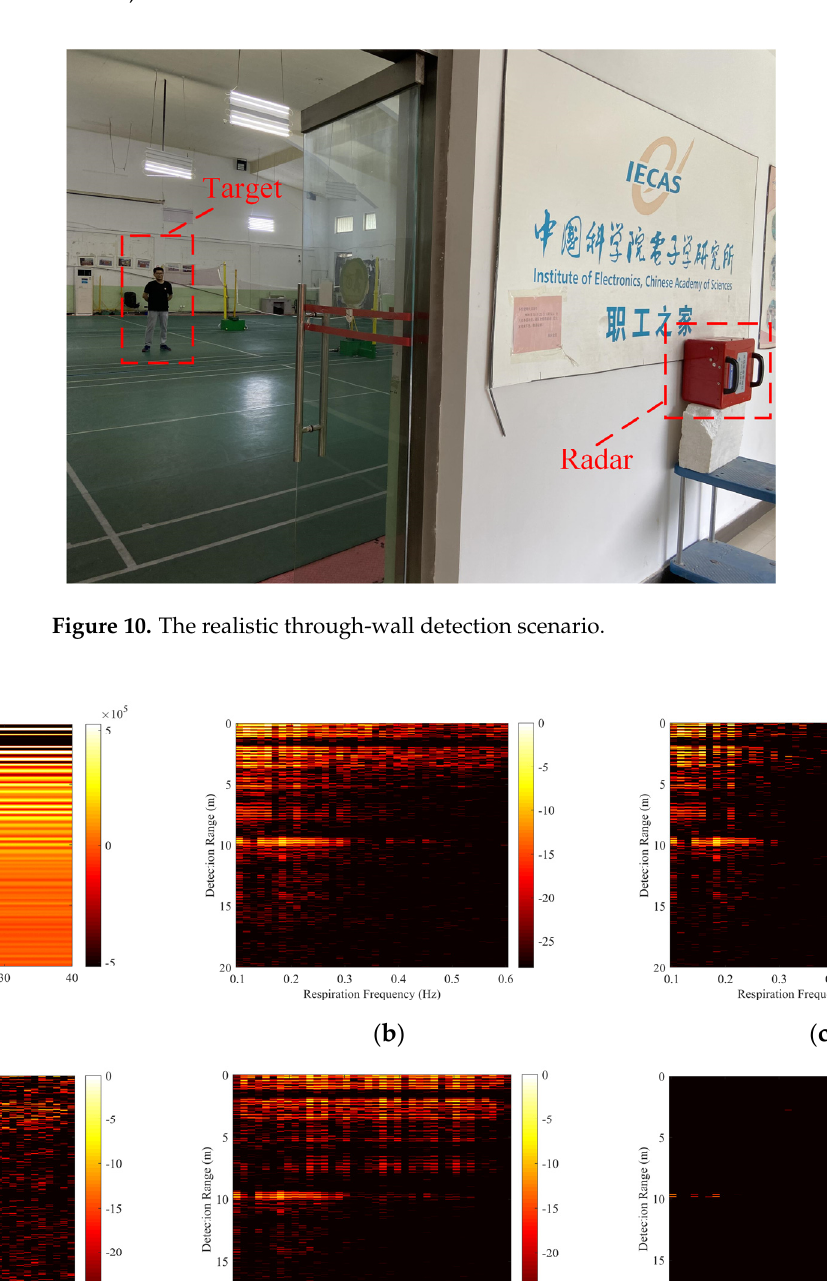
Figure 10. The realistic through − wall detection scenario.